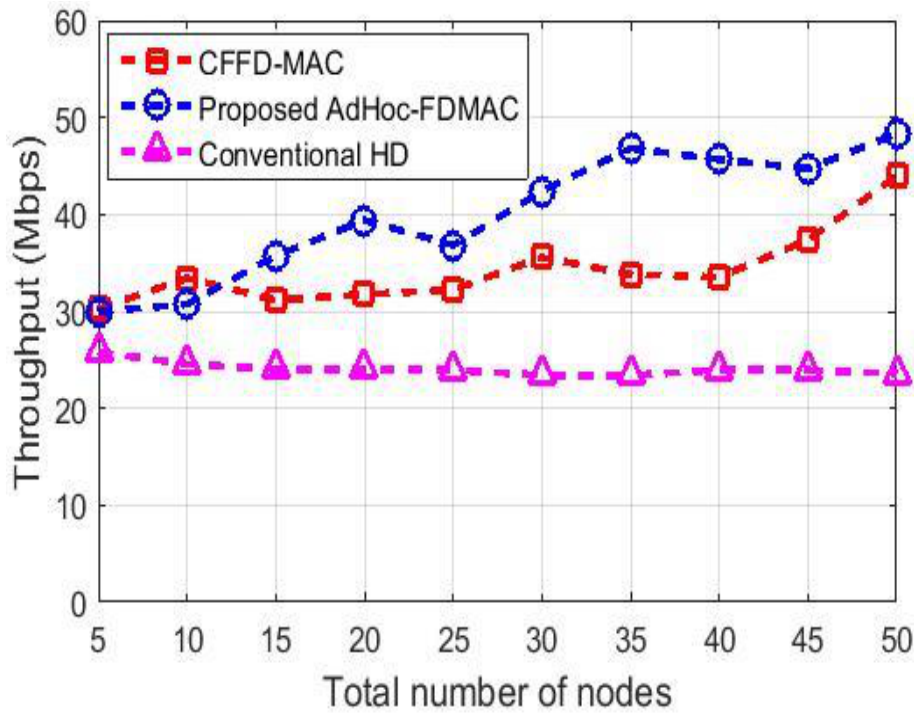
Figure 10. Throughput comparison.